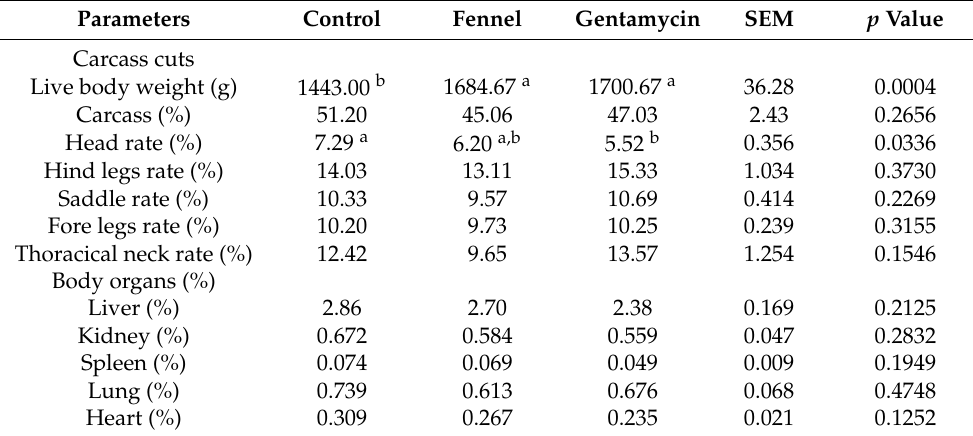
Table 4. Impact of dietary fennel oil or gentamycin on the relative weights of carcass cuts and internal organs of weaned Moshtohor rabbits aged 12